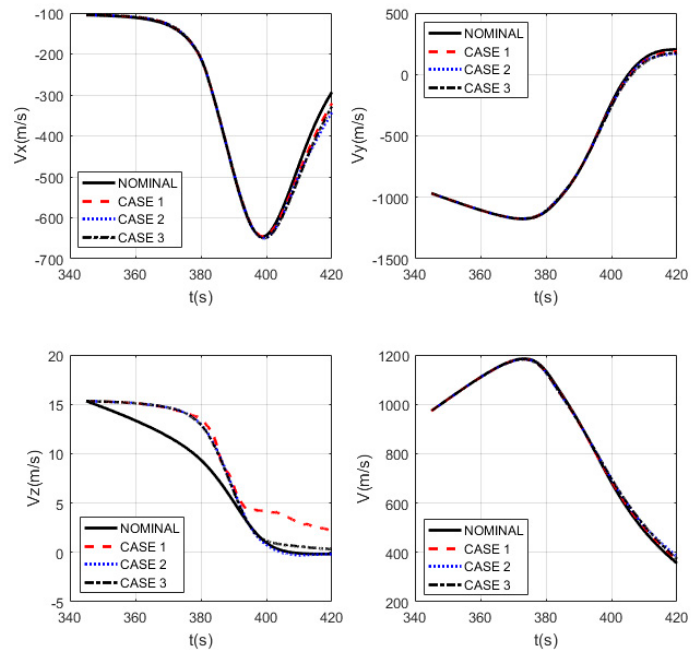
Figure 5. The flight velocities of the RLV.